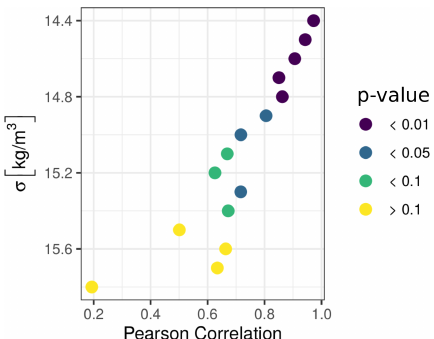
Figure 6. Pearson correlation coefficient between basin-wide an- nual oxygenation and CIL formation estimates for different σ lay- ers. Color of the points relates to the order of magnitude of associ- ated p